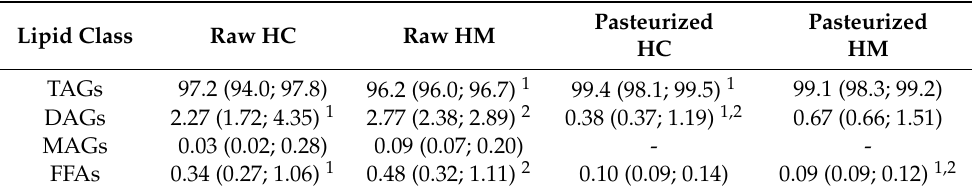
Pasteurized Pasteurized HC HM